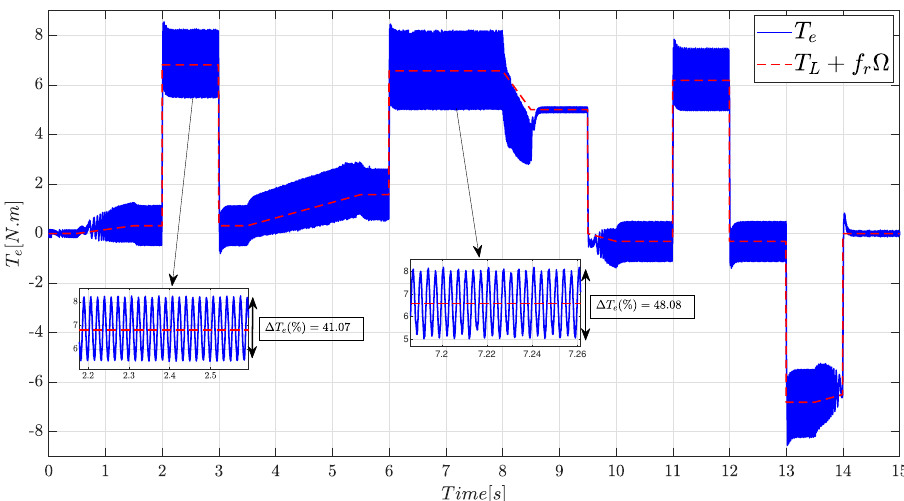
Figure 8. Torque response obtained by PI controllers and conventional field-oriented control.